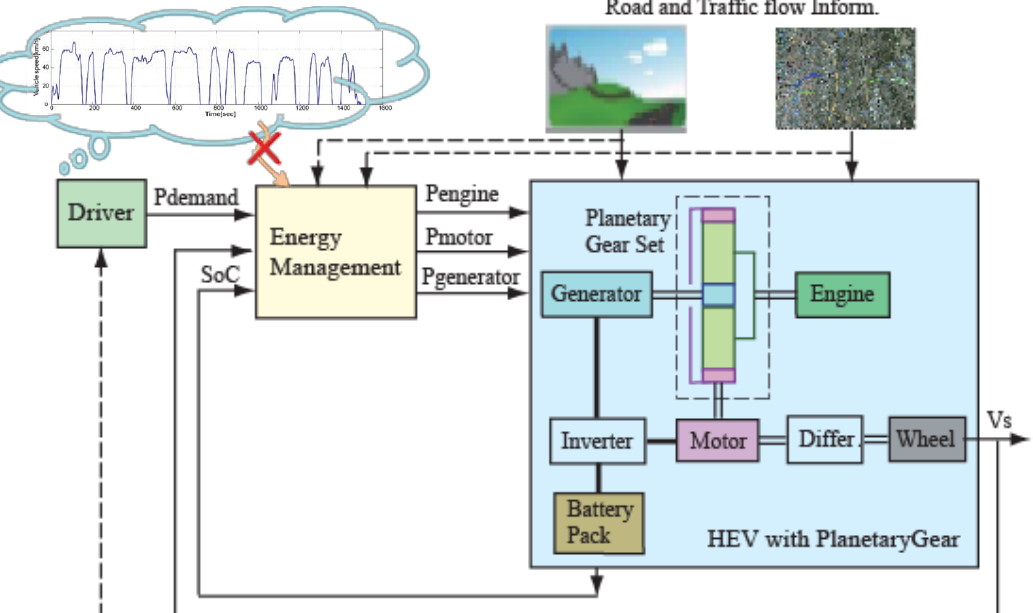
Figure 5. System configuration of the HEV with energy management using traffic